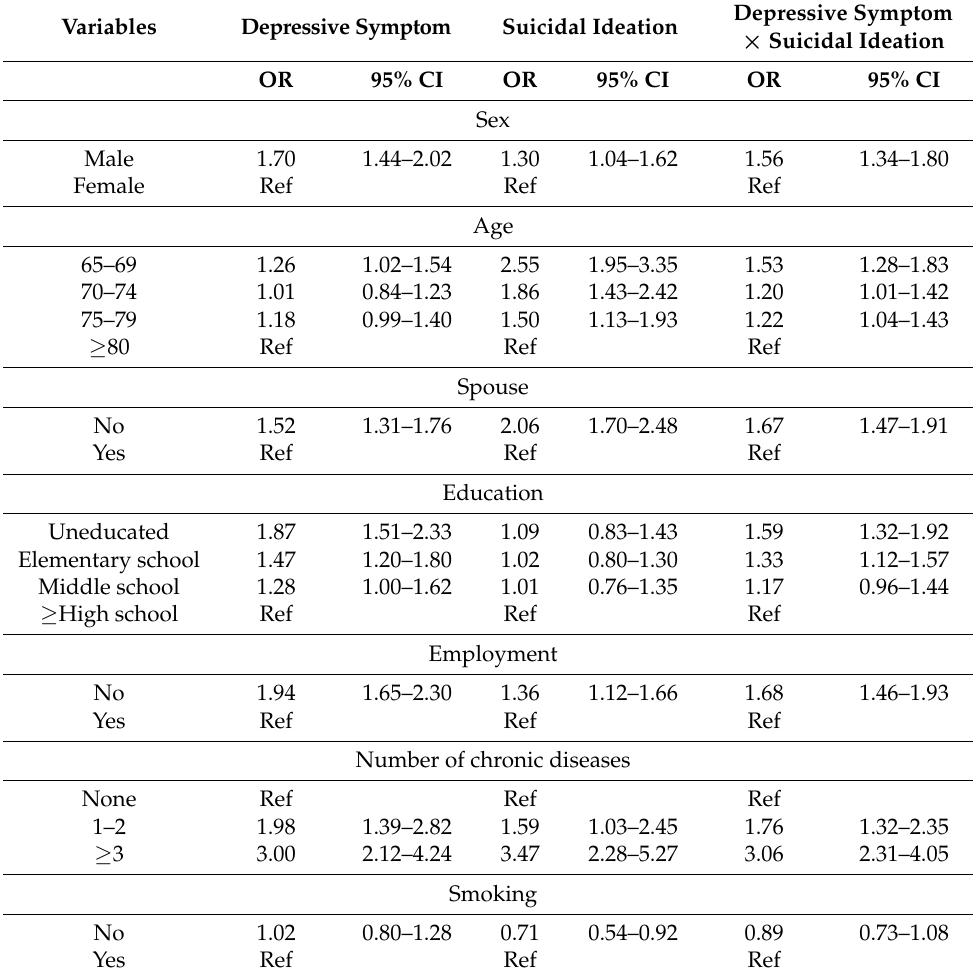
Table 2. Factors associated with depressive symptom and suicidal